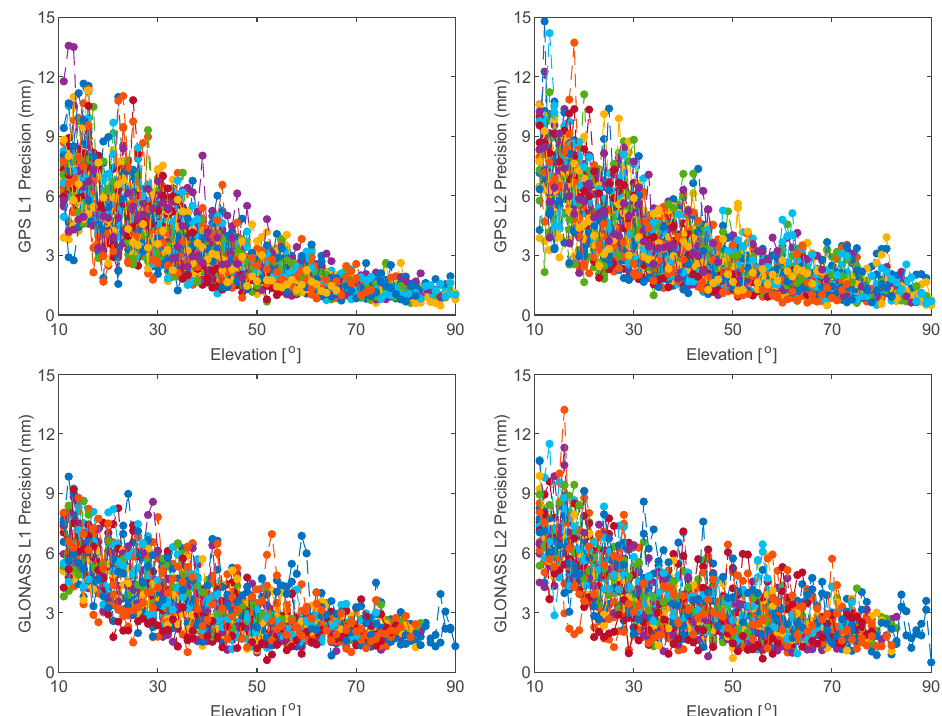
Figure 7. Phase precision estimation of every one-degree elevation for GPS and GLONASS.